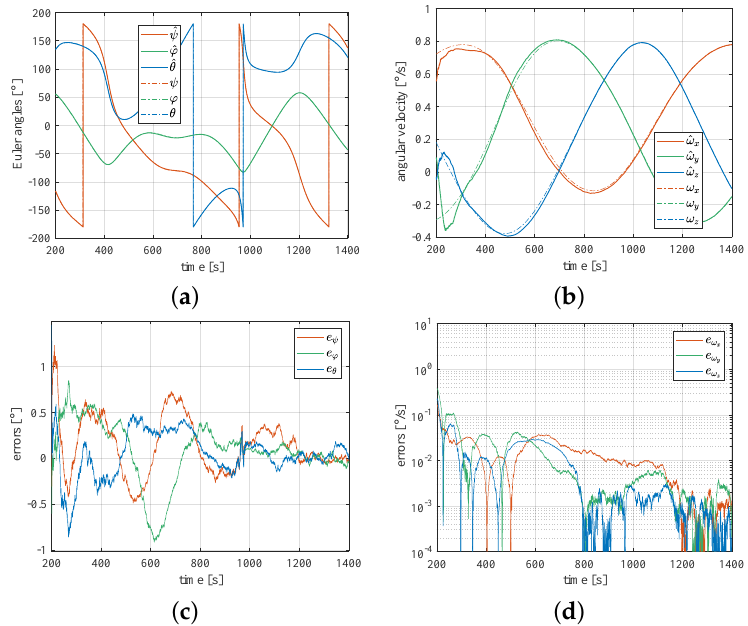
Figure 6. The estimations of the attitude of the object after the collision: ( a ) estimations of the Euler angles; ( b ) estimations of the angular velocity components; ( c ) errors of the Euler angle estimations; ( d ) error of the angular velocity estimation.